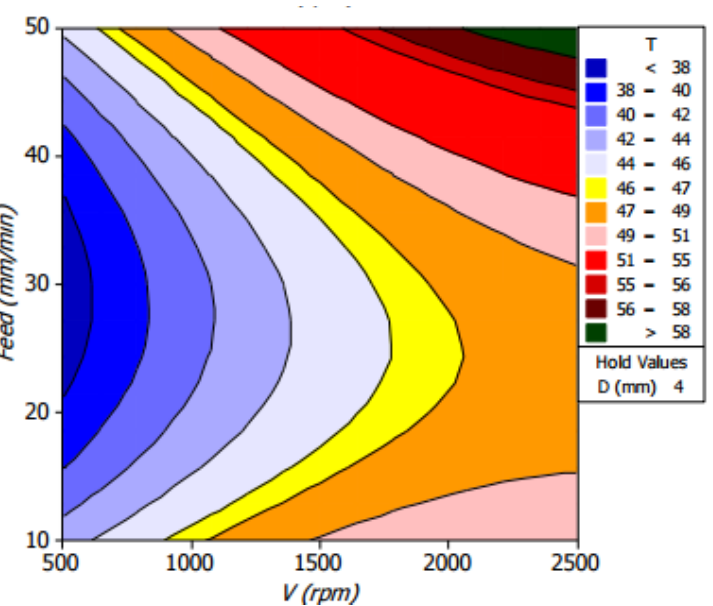
Figure 1: Temperature diagram of feed rate and rotational speed with drill bit diameter of 4 mm